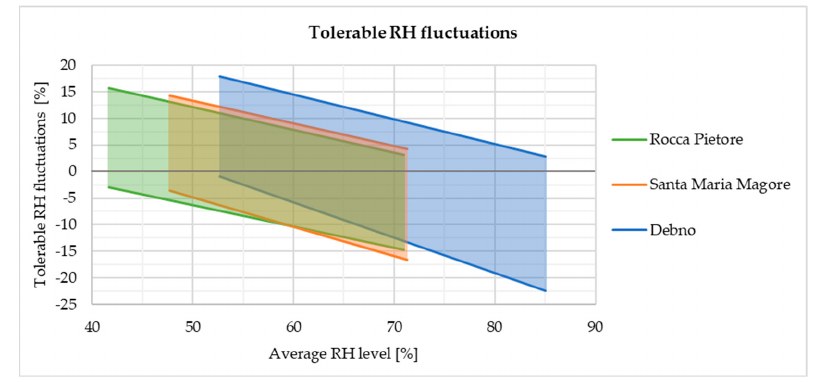
Figure 5. Tolerable relative humidity (RH) fluctuations in a trio of churches